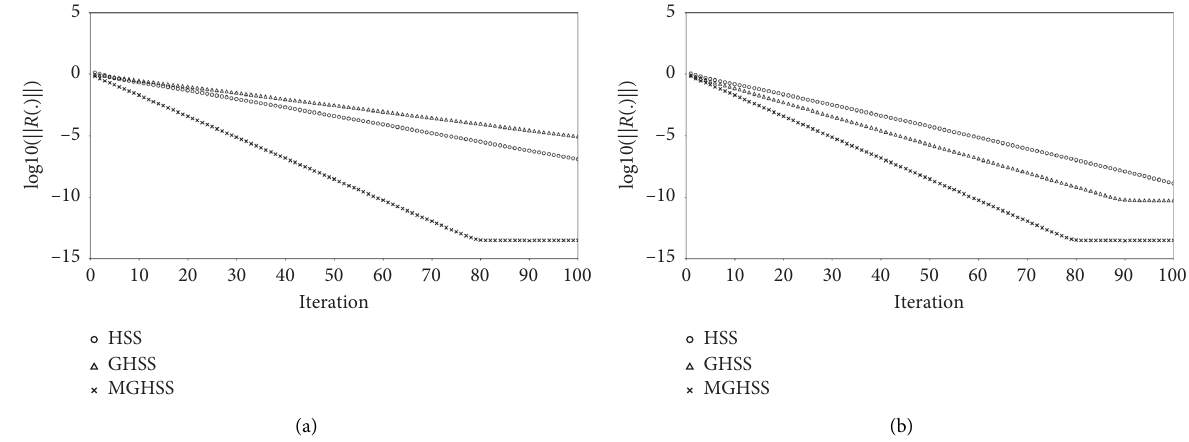
Figure 1: The logarithm ‖ R ( X ( k ) )‖ versus iteration of the HSS, GHSS, and MGHSS Table 5: Comparisons of HSS, GHSS, and MGHSS in terms of n t . is and HSS GHSS MGHSS n t n is is